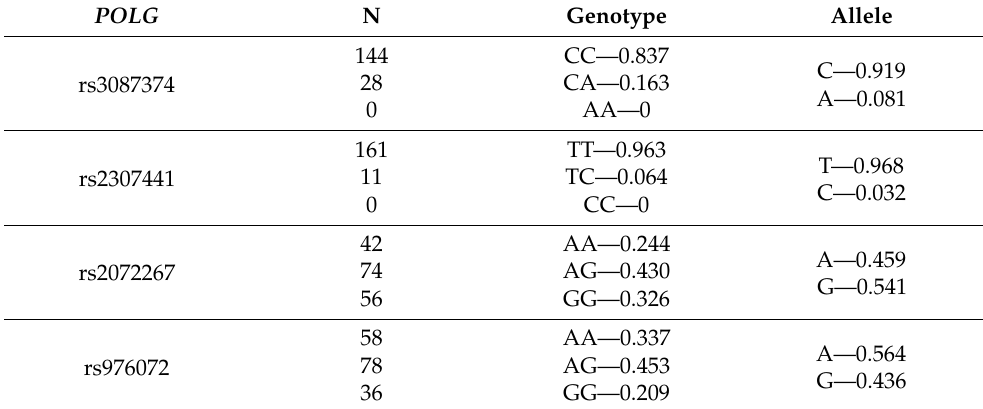
Table 1. The frequency of POLG genotypes and